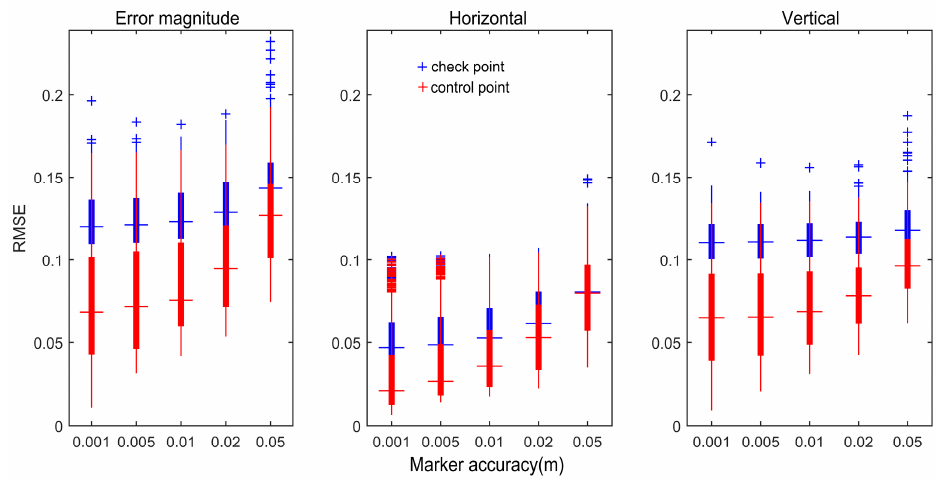
Figure 3. Monte Carlo analysis of control points and check points.